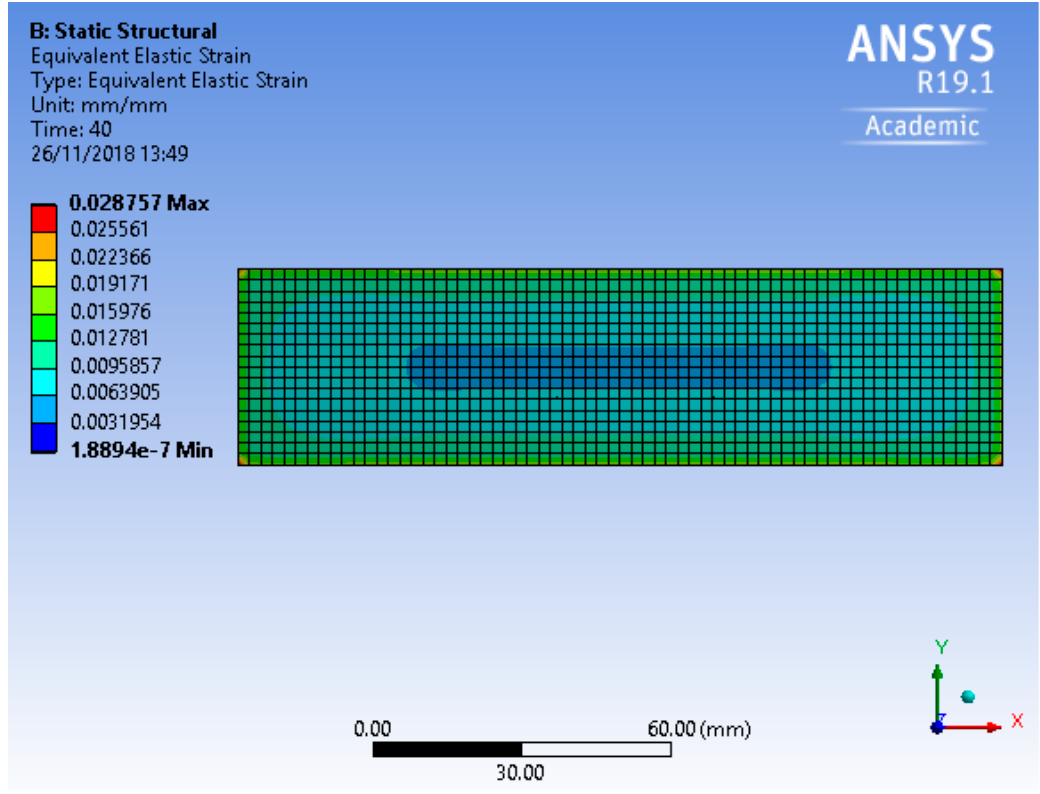
Figure 7. Hot plate showing thermal stress.